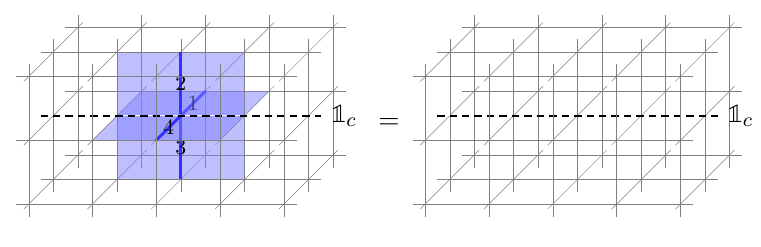
Figure 13. The fusion of two z -particles is z ◦ z = 1 1